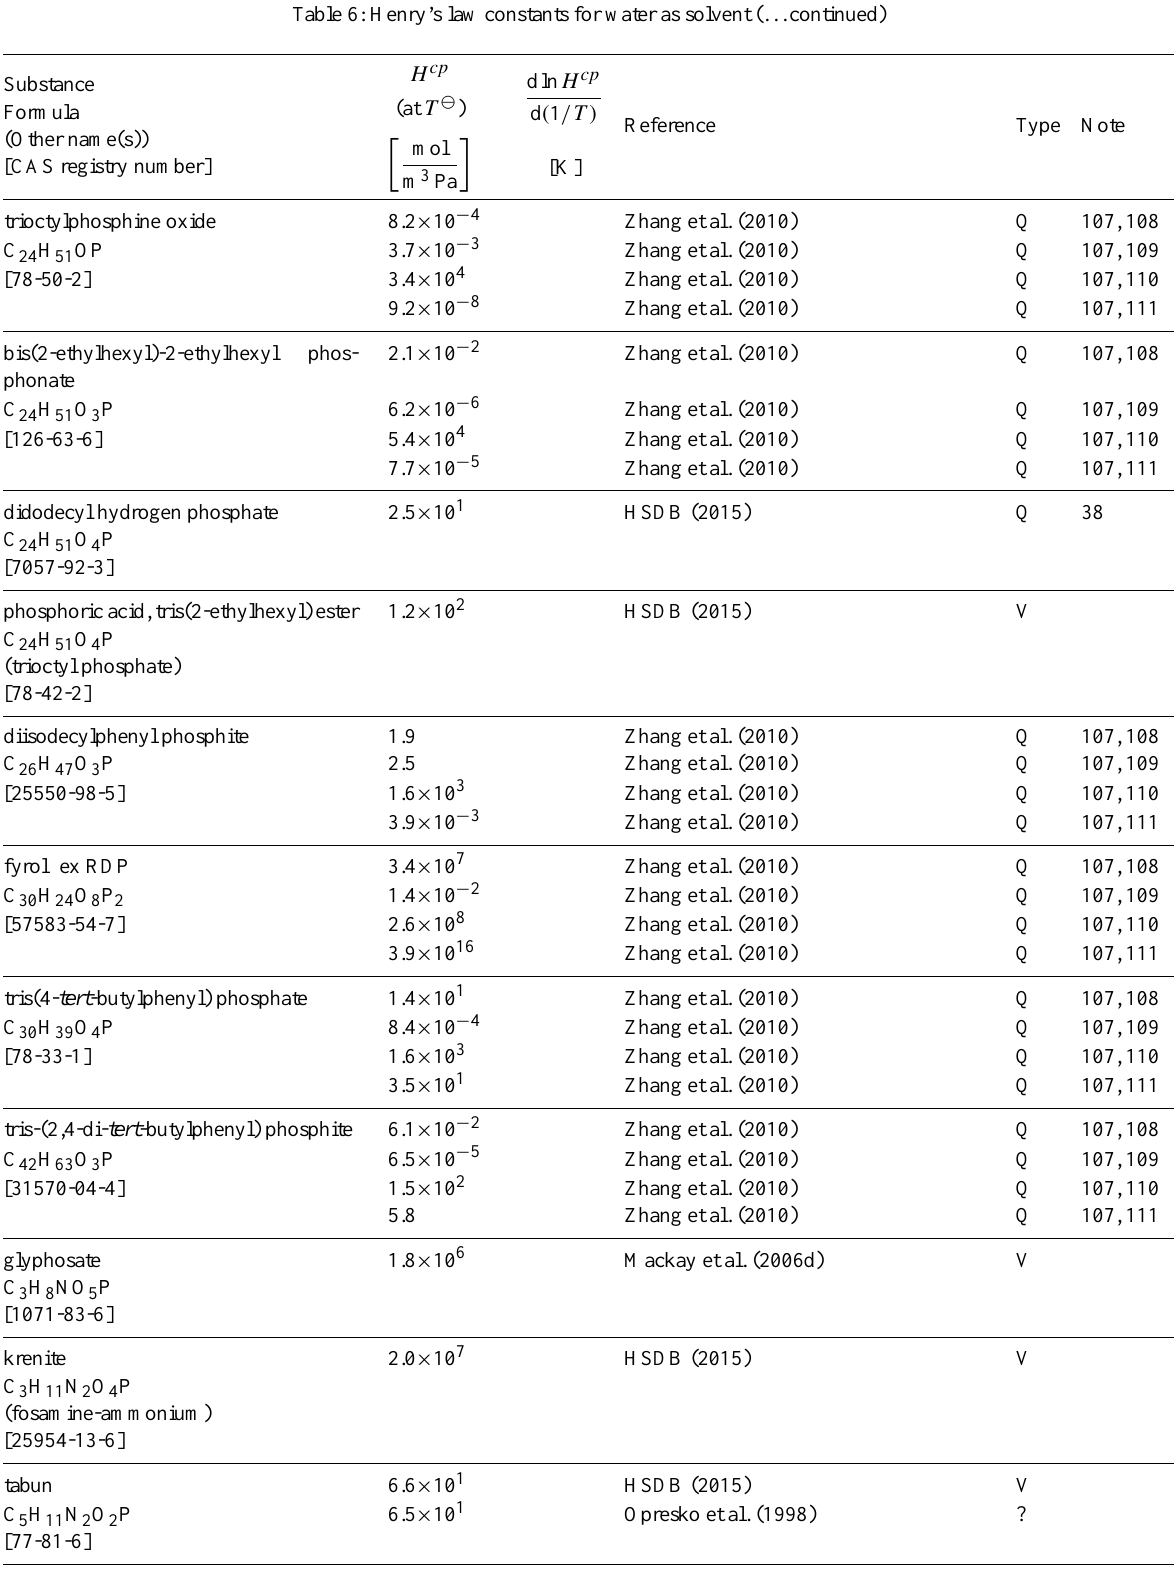
Table 6: Henry’s law constants for water as solvent